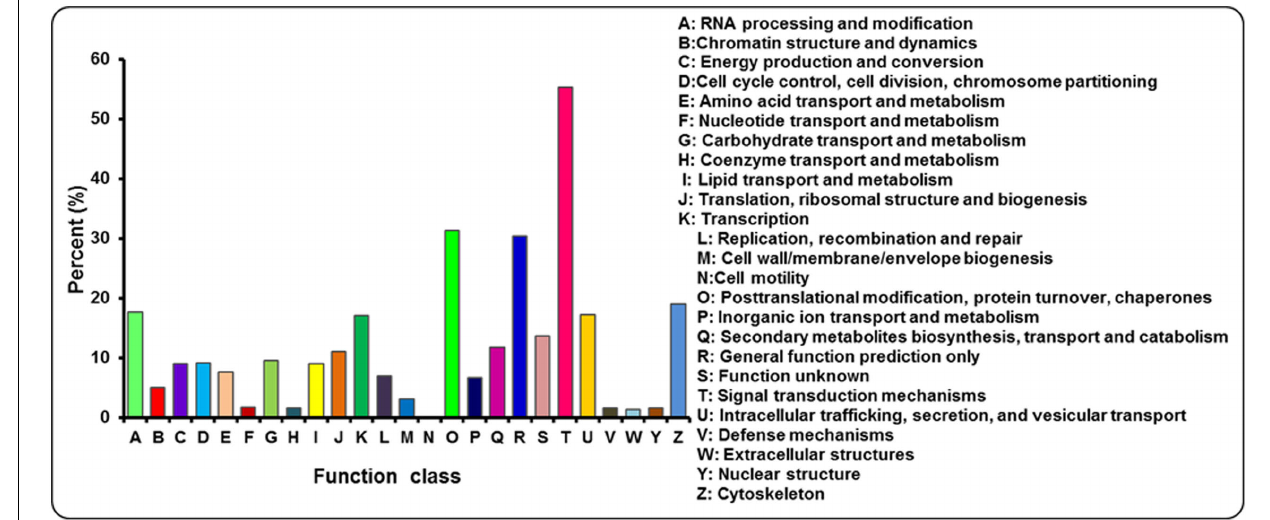
FIGURE 5 | COG functional classification for leaves and roots transcriptome of A. bidentata